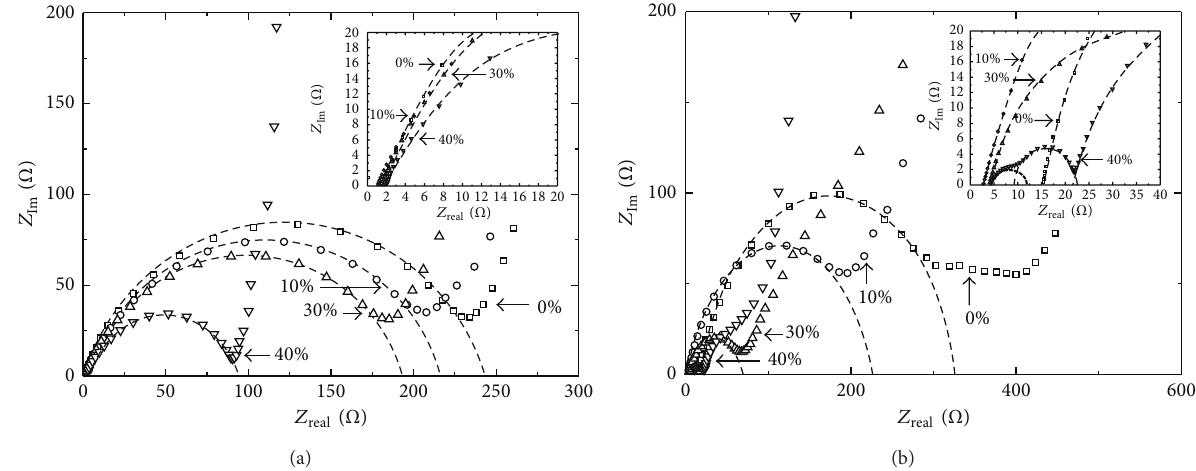
Figure 6: Nyquist plots for the SiO 𝑥 anode samples with different amounts of pitch carbon (0wt% to 40wt%) at a fixed amount of 10wt% of conductive carbon blacks; (a) as-prepared cells and (b) after the 50th discharging